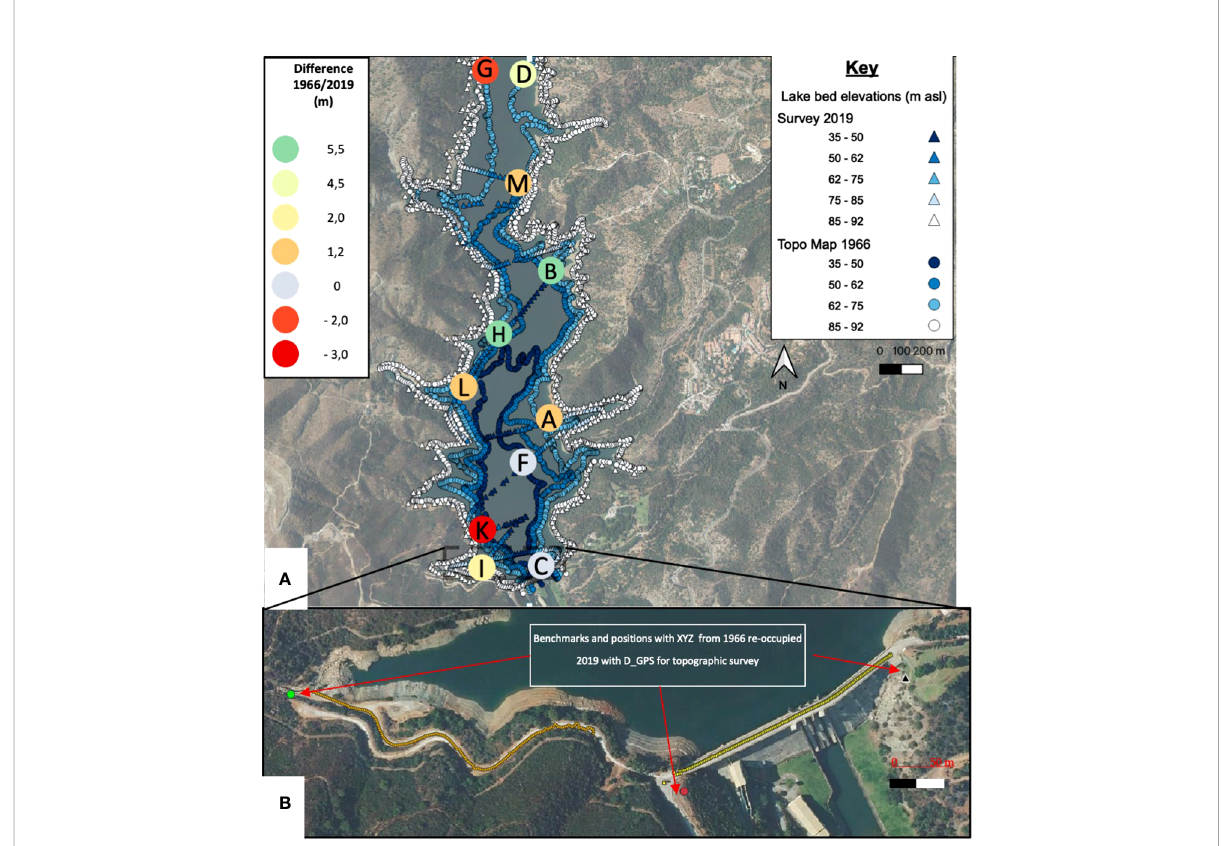
FIGURE 5 (A) Location of original digitized and surveyed elevations from 1966 to 2019 and spot heights used for comparison. Color in labels indicates the sedimentation/erosion observed in the comparison between 1966 and 2019 in meters. The letter inside the circle symbol refers to the letter mentioned in the text. (B) Benchmarks and positions with XYZ coordinate provided by the blueprint documents of dam construction from 1966. Points and marked ways were reoccupied in 2019 with D_GPS to establish the link between topographic surveys.